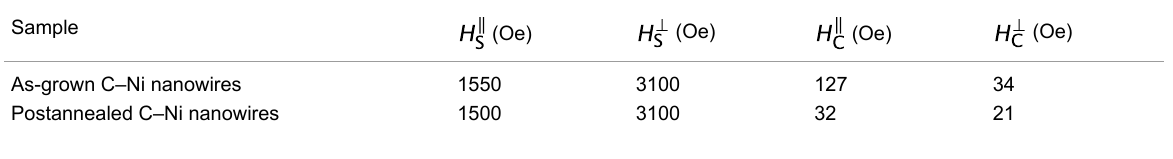
Table 1: Summary of the magnetic characteristics recorded at 300 K for C–Ni nanowire arrays before and after thermal annealing at 400 °C. Sample